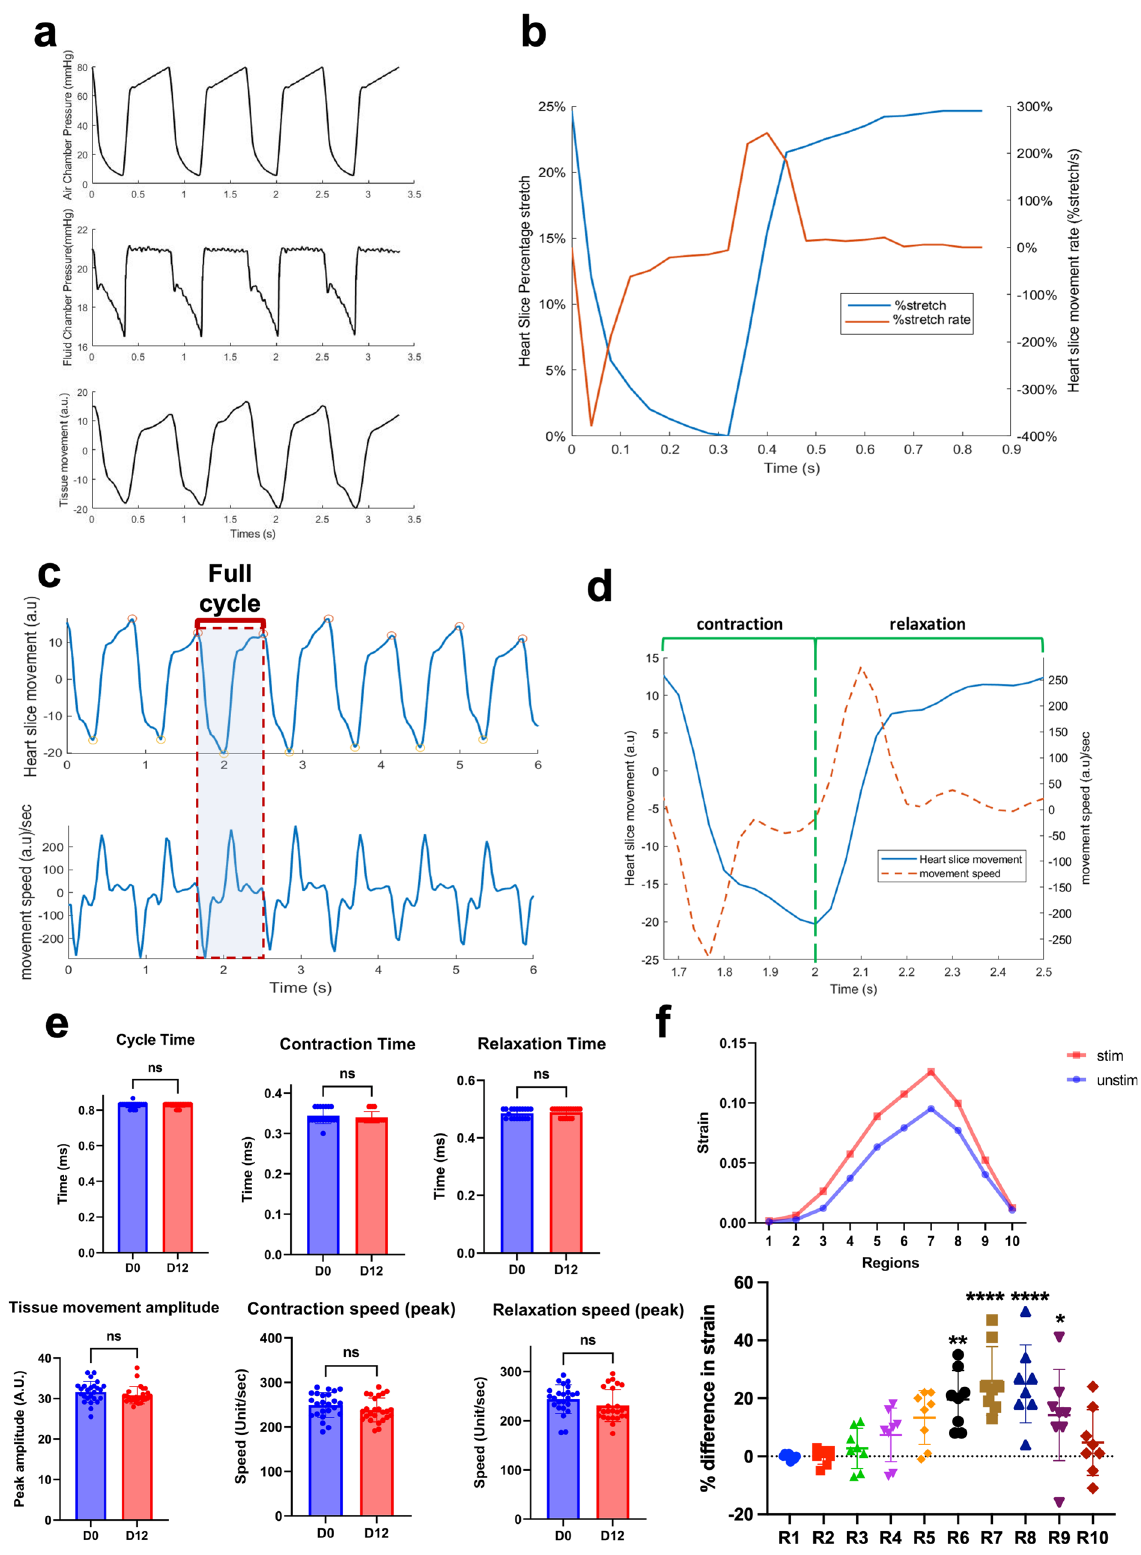
and fl uorescent intensity. This technique uses a convolutional neural network (CNN) and the deep learning framework to reliably quantify the cardiac tissue structural integrity in an automated and unbiased manner, as described in ref. 26 . MC tissue showed an improved structural similarity to day 0 com- pared to the static control slices. Furthermore, Masson ’